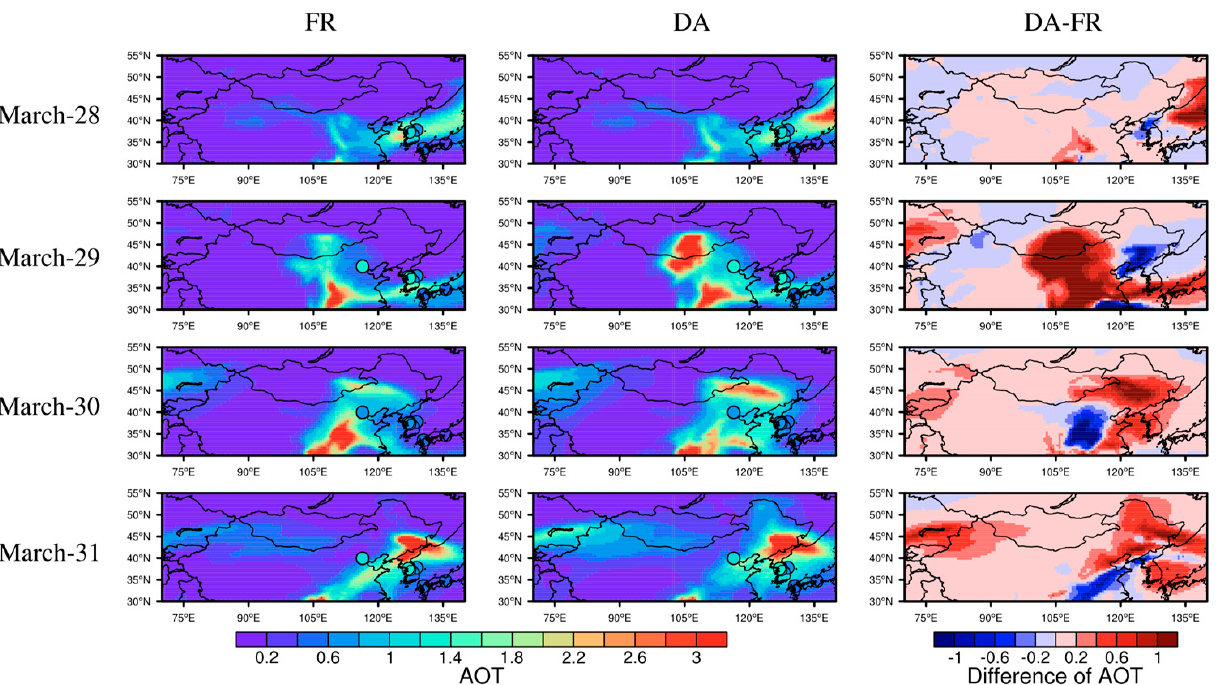
Figure 5. Spatial distributions of the total AOTs from 28 to 31 March 2018 for FR and DA experiments with differences in total AOTs between the two experiments. The daily mean AOTs in “dusty” stations from AERONET are also shown in circles.